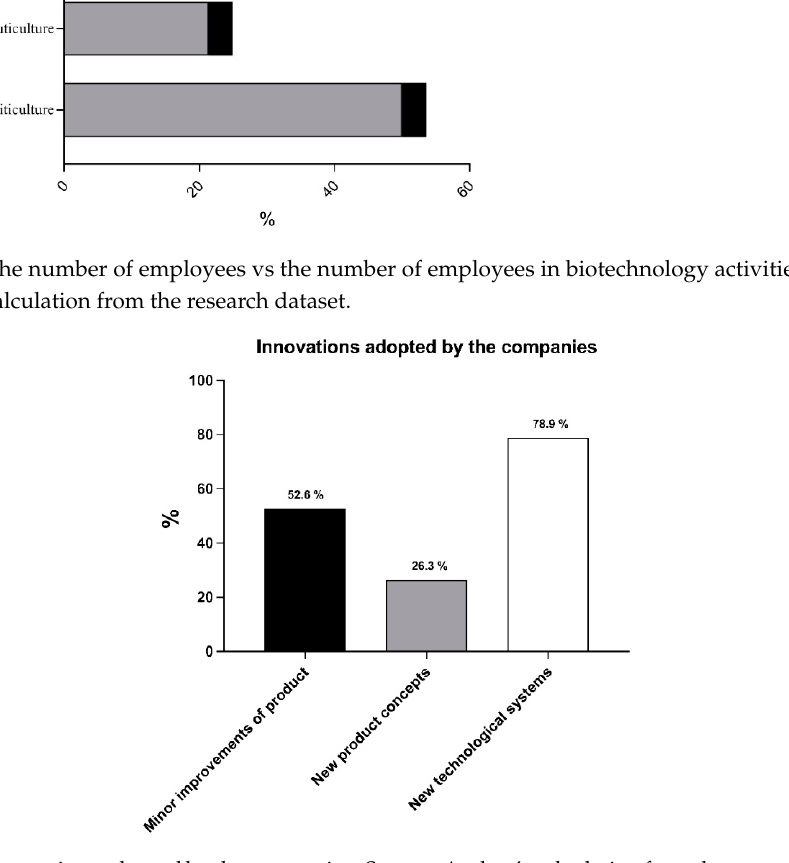
Figure 2. The number of employees vs the number of employees in biotechnology activities . Source: Author’s calculation from the research dataset.